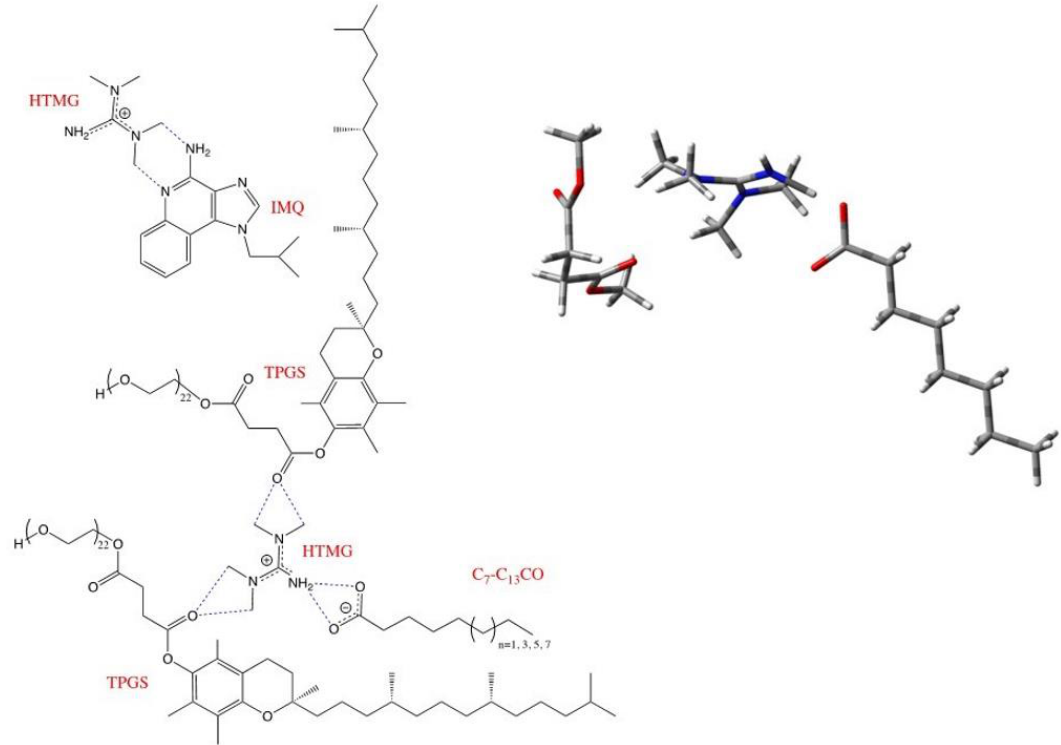
Scheme 2. Left: Scheme of the possible molecular interactions in C 7 -C 13 CO-HTMG-TPGS / Nano and HTMG-IMQ / Nano (potential hydrogen bonds are highlighted in blue). Right: DFT optimized structure of a 1:1:1 cluster of C 7 CO-HTMG-Model of TPGS. In the model, TPGS has been reduced to a